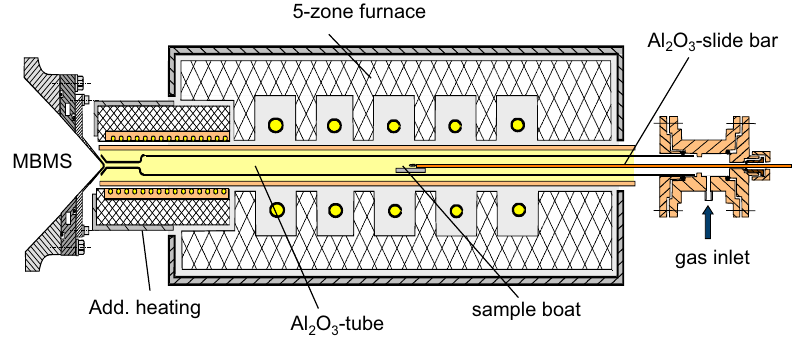
Figure 4: Setup used for vaporization experiments, from Wolf et al. [ 54 ] .